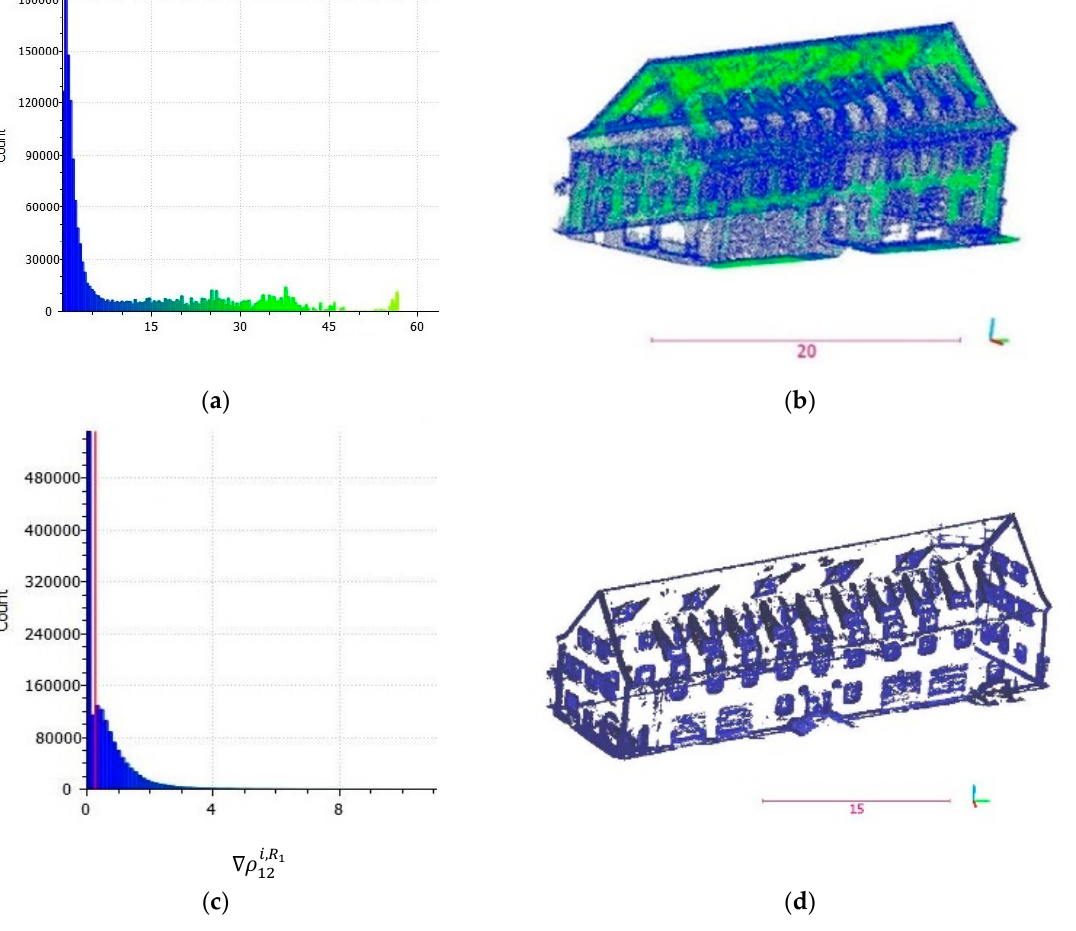
Figure 6. Filtering the point cloud. ( a ) Histogram of ρ 12 . ( b ) Labelling the point cloud (in m). ( c ) Thresholding the histogram of ∇ ρ i , R 1 . ( d ) The filtered point cloud (in